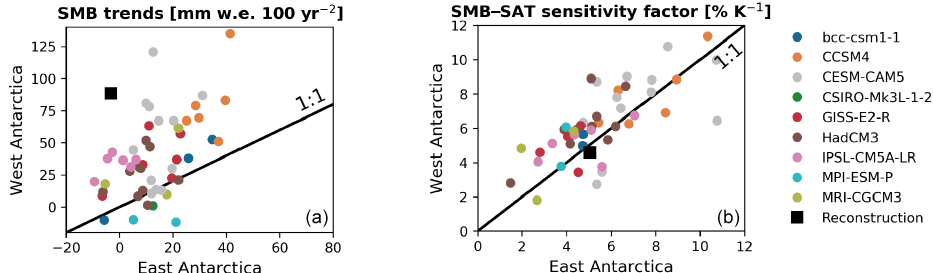
Figure 3. (a) Comparison between the reconstructed and the simulated SMB trends (mmw.e.100yr − 2 ) over the period 1950–2000CE in West Antarctica ( y axis) and East Antarctica ( x axis). (b) As on the left but for SMB–SAT sensitivity factors (%K − 1 ). For the reconstruction, data from Thomas et al. (2017) and Nicolas and Bromwich (2014a) are